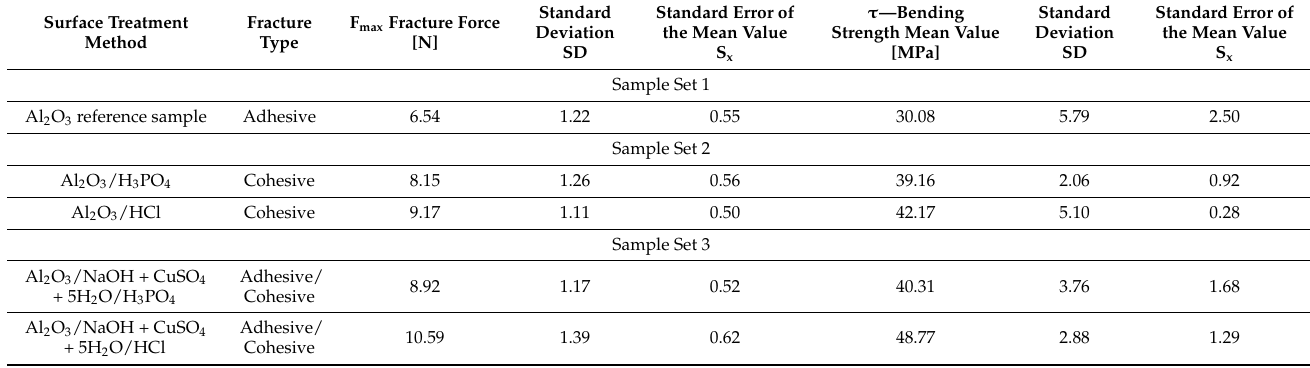
Table 3. Results of mechanical tests (three-point bending) for all variants of Ti 99.2—Duceratin Kiss samples after chemical and mechanical surface treatment.